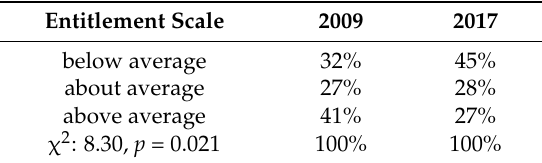
Table 1. Entitlement Scale Distribution: 2009 versus 2017.